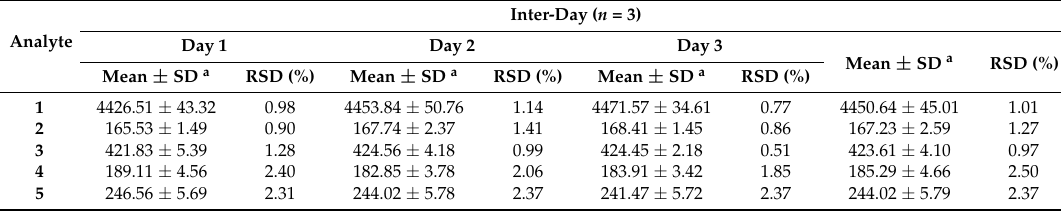
Table 2. Intra-day and inter-day variations of analytes in Pyrrosiae Folium sample (Batch 1).